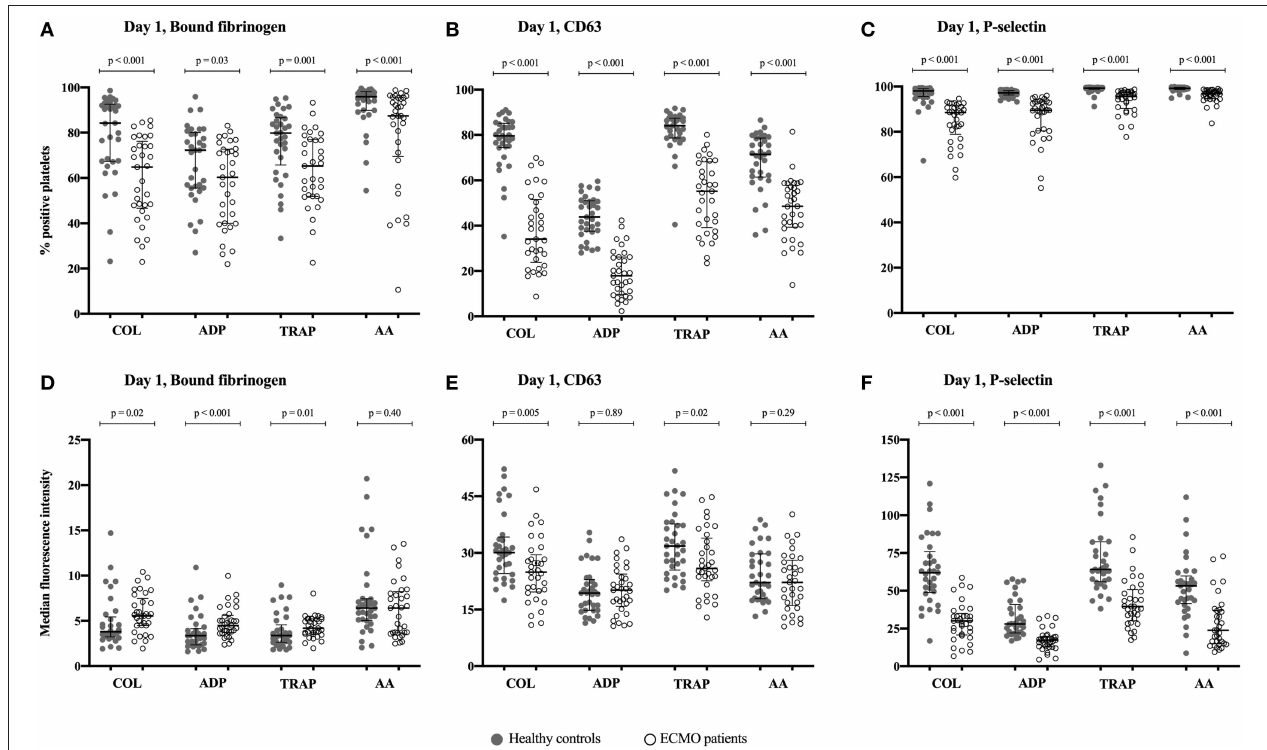
FIGURE 3 | Illustrates the degree of platelet activation in response to stimulation by four different agonists. The degree of activation can be measured as a change in the expression of the activation-dependent platelet surface markers bound-fibrinogen, CD63 and P-selectin on day 1 of support with extracorporeal membrane oxygenation (ECMO). The results are compared with healthy controls, n = 33. (A–C) The percentage of activated platelets in response to stimulation by an agonist; (D–F) The median fluorescence intensity (MFI) of the activated platelets following stimulation by an agonist. Agonists used to activate the platelets: